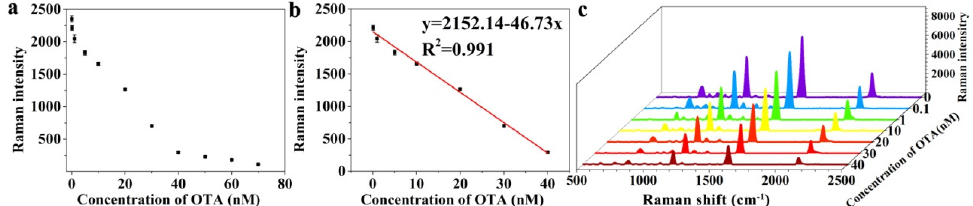
Figure 5. Analytical performance of the aptasensor: ( a ) SERS intensity difference at the peak of 1998 cm − 1 with the different OTA concentrations, ( b ) linear relationship between SERS intensity and OTA concentration, ( c ) SERS spectra for OTA detection in the concentration range of 0–40 nM.